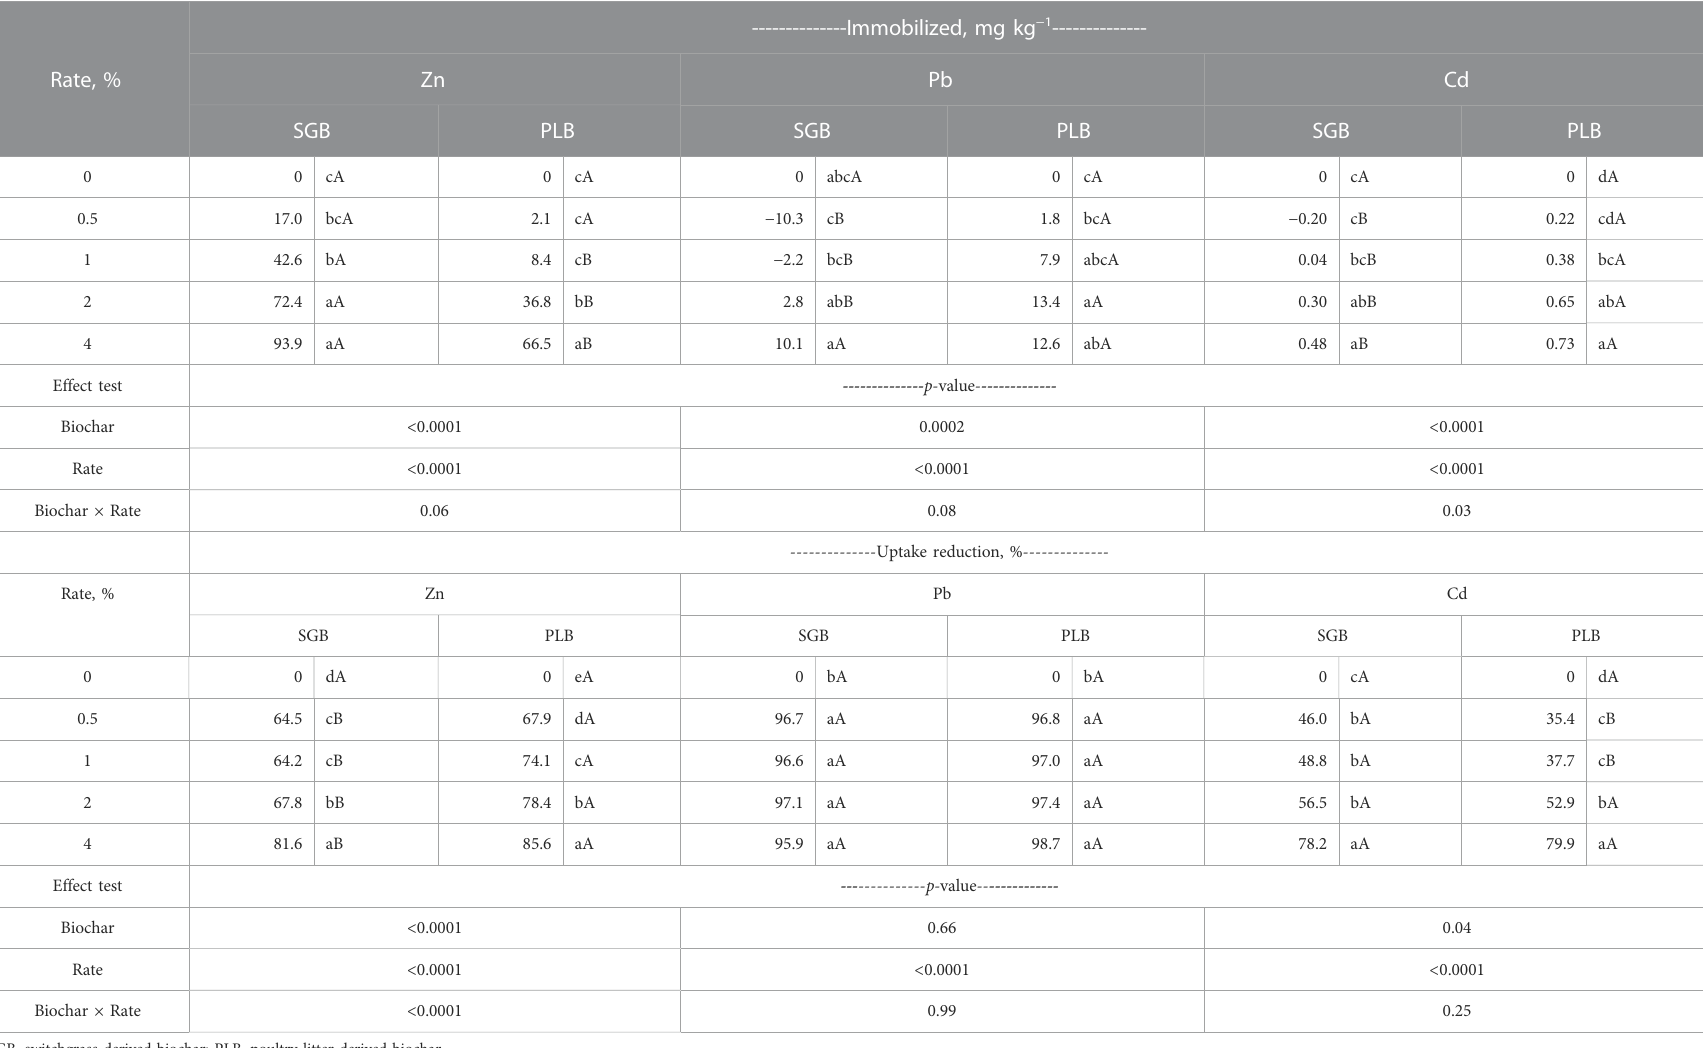
SGB, switchgrass-derived biochar; PLB, poultry litter-derived biochar. For each heavy metal, different lowercase letters in columns and uppercase letters in rows are signi fi cantly different at p < 0.05